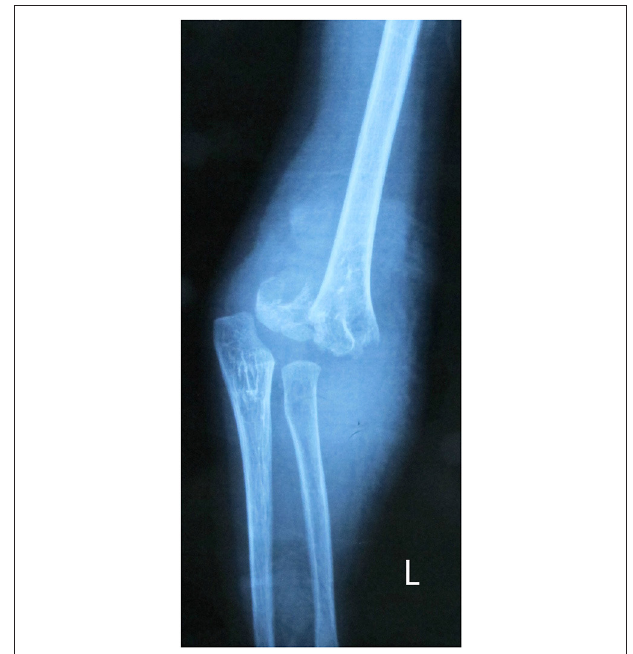
FIGURE 1 | Gartland type III supracondylar fracture of a 4-year-old girl.